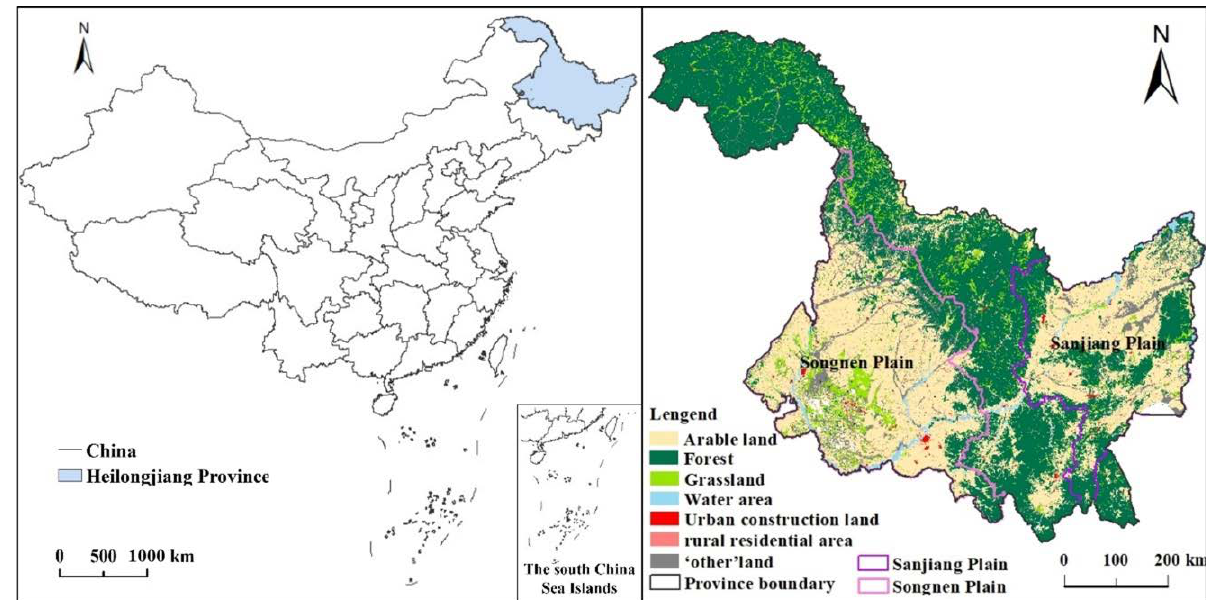
Figure 1. The geographical location of the Heilongjiang province and its land use in 2014.